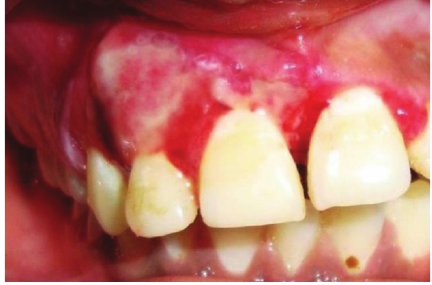
Figure 10: 1-week postoperative photograph.